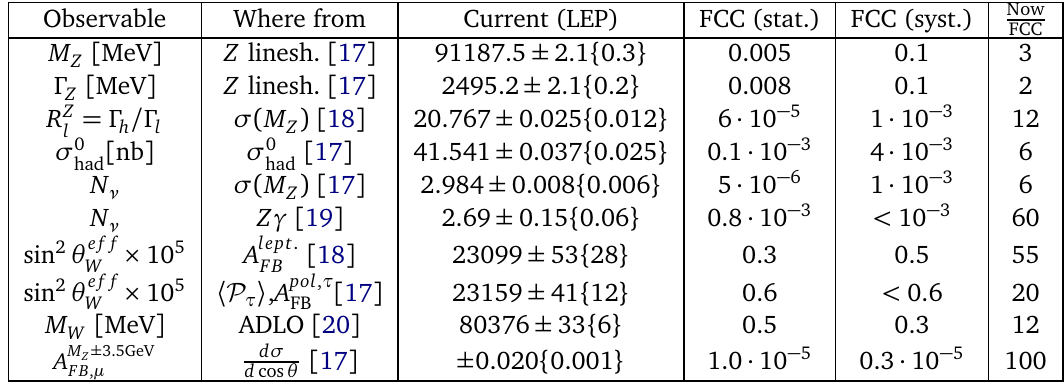
Table 1: The current systematic and statistical uncertainties on QED sensitive ob- servables, with terms in { ... } denoting the contributions to QED alone. The FCC-ee uncertainty estimates have been taken from [ 21 ] , the overall table has been repro- duced from [ 22 ] Observable Where from Current (LEP) FCC (stat.) FCC (syst.) Now [ MeV ] Z linesh. [ 17 ] 91187.5 ± 2.1 { 0.3 } 0.005 0.1 3 M Z Γ [ MeV ] Z linesh. [ 17 ] 2495.2 ± 2.1 { 0.2 } 0.008 0.1 2 Z = Γ / Γ σ ( M ) [ 18 ] 20.767 ± 0.025 { 0.012 } 6 · 10 − 5 1 · 10 − 3 12 R Z h l Z l σ 0 [ nb ] σ 0 [ 17 ] 41.541 ± 0.037 { 0.025 } 0.1 · 10 − 3 4 · 10 − 3 6 had had ) [ 17 ] 2.984 ± 0.008 { 0.006 } 5 · 10 − 6 1 · 10 − 3 6 N ν σ ( M Z N ν Z γ [ 19 ] 2.69 ± 0.15 { 0.06 } 0.8 · 10 − 3 < 10 − 3 60 × 10 5 A lept . [ 18 ] 23099 ± 53 { 28 } 0.3 0.5 55 sin 2 θ ef f W FB × 10 5 〈 [ 17 ] 23159 ± 41 { 12 } 0.6 < 0.6 20 〉 , A pol , τ sin 2 θ ef f τ W FB P [ MeV ] ADLO [ 20 ] 80376 ± 33 { 6 } 0.5 0.3 12 M W ± 3.5GeV d σ [ 17 ] ± 0.020 { 0.001 } 1.0 · 10 − 5 0.3 · 10 − 5 A M Z d cos θ FB , µ